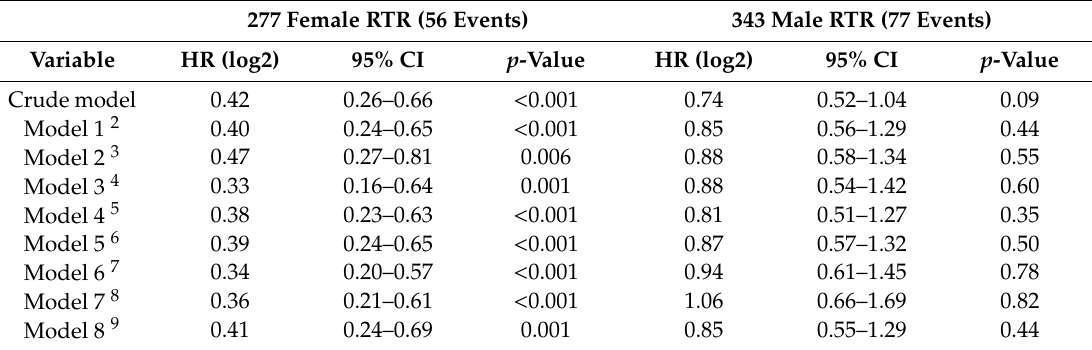
Table 3. Association between log2-transformed plasma IGF1 levels and the risk of all-cause mortality in female and male RTR 1 .